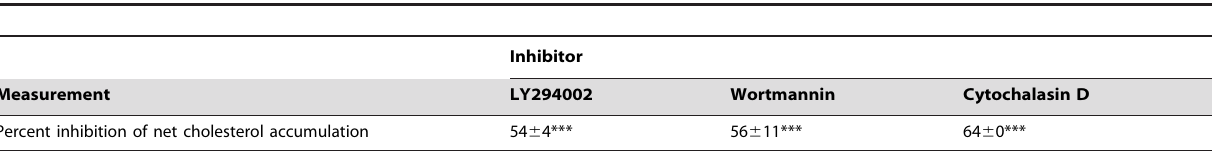
Percent inhibition of net cholesterol accumulation Wild-type bone marrow-derived macrophages were pretreated 1 h with either drug vehicle, 50 m M LY294002, 100 nm wortmannin, or 4 m g/ml cytochalasin D. Macrophages then were incubated with 1 mg/ml LDL and inhibitor for 6 h. Incubations were performed in serum-free medium containing 50 ng/ml M-CSF. The percent inhibition of net cholesterol accumulation compares macrophages treated with LDL alone and LDL with inhibitor after basal cholesterol values were subtracted from each. **= p , 0.01. ***= p , 0.001. All inhibitors almost completely inhibited macropinosome formation as assessed by phase-microscopy. For the LY294002 experiment,